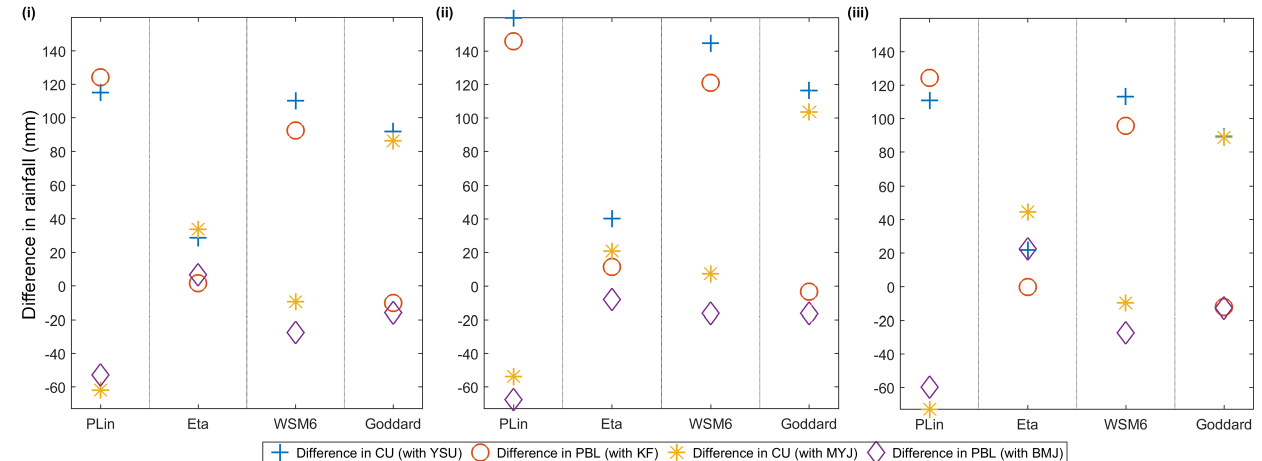
Figure 10. Difference in simulated rainfall due to PBL, CU and MP parameterization schemes corresponding to (i) Domain 1, (ii) Domain 2a and (iii) Domain 2b over the UGB region.